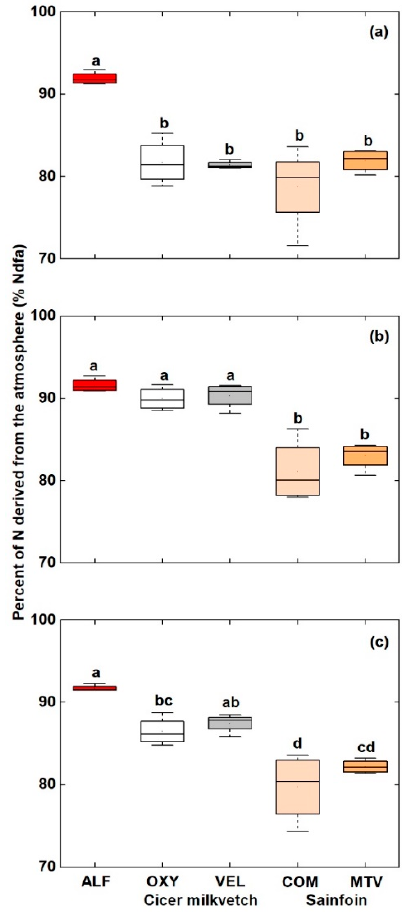
Figure 1. Nitrogen derived from the atmosphere (% Ndfa) in the shoot ( a ), root ( b ), and whole plant ( c ) among legume species and cultivars ( n = 4) grown under controlled environment conditions. ALF = alfalfa, OXY = Oxley II milkvetch, VEL = Veldt milkvetch, COM = Common sainfoin, MTV = Mountainview sainfoin. The box is comprised of the 75th percentile, median, and 25th percentile, while the upper and lower whiskers are the maximum and minimum values, respectively. Boxes with the same letters indicate no significant differences among legume cultivars within a panel ( p > 0.05) according to Tukey’s HSD test.